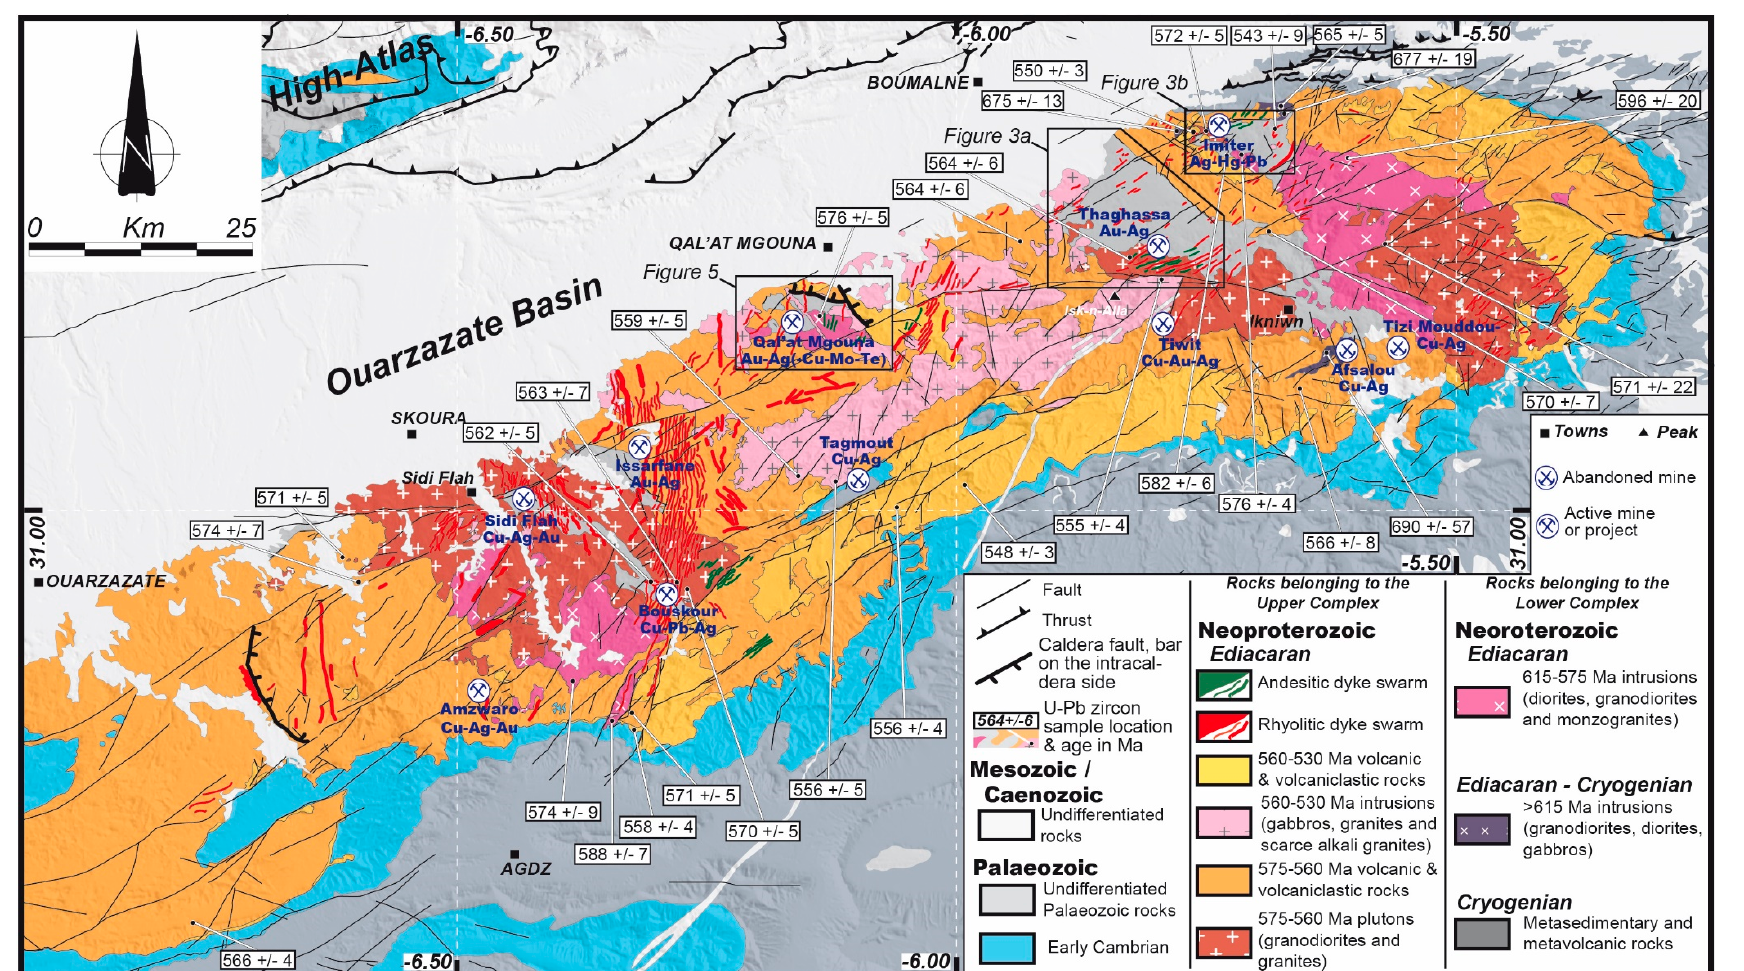
Figure 2. Simplified geologic map of the Jbel Saghro, after Hindermeyer et al. [104], Tuduri [47] and Tuduri et al. [48]. U ‐ Pb radiometric ages obtained on zircon [29,48,51,78,105 – 108].